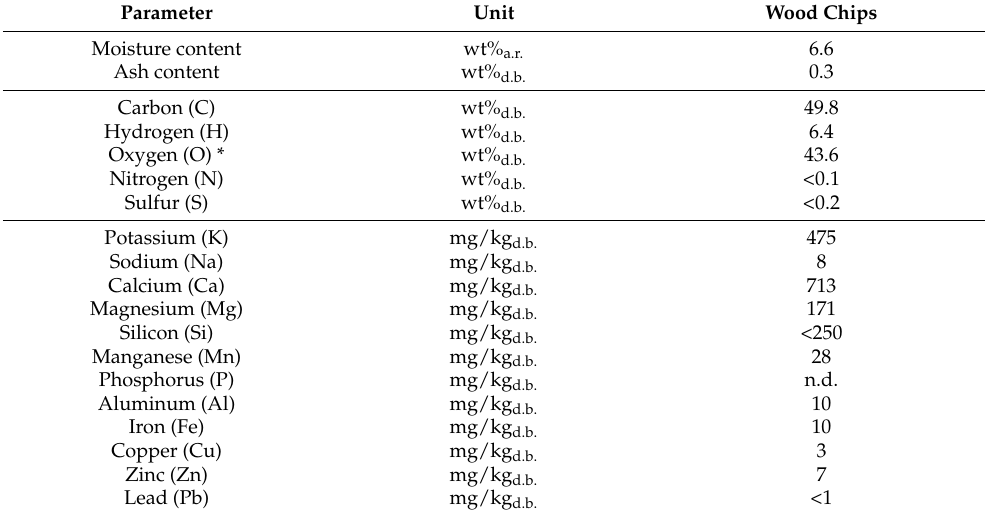
Table 1. Fuel properties and chemical composition of the wood chips according to DIN EN ISO 17225-1 (a.r.: wood chips as received, d.b.: dry wood chip basis, *: calculated by mass difference, n.d.: not determined)